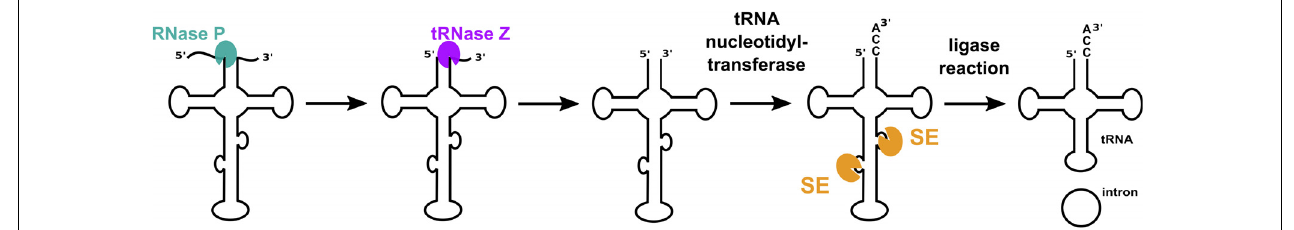
FIGURE 1 | tRNA maturation in archaea. Functional mature tRNAs are obtained after several processing steps. The 5 (cid:48) leader and 3 (cid:48) trailer sequences are removed by the endonucleases RNase P and tRNase Z. A terminal CCA triplet is added to the 3 (cid:48) end by tRNA nucleotidyl transferase. Introns are removed by a splicing endonuclease (SE), exons are ligated, and the intron is circularized by an RNA ligase. The order of the processing steps can differ from organism to organism.